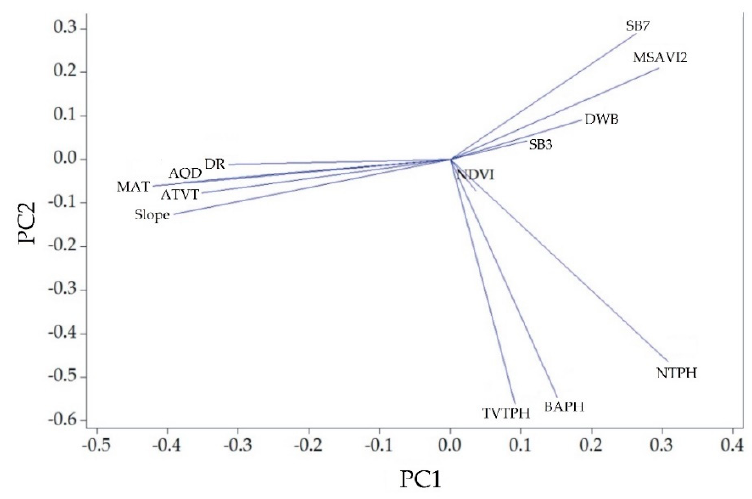
Figure 4. Loading plot of the first two principal components (PC) showing the contribution of each variable.